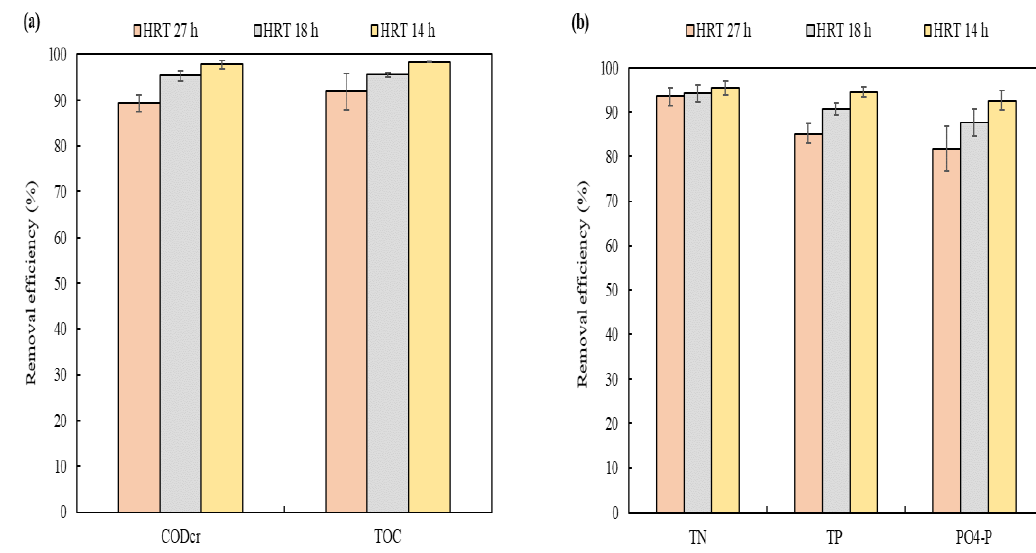
Figure 3. Removal e ffi ciency of ( a ) organic matter and ( b ) nitrogen and phosphorus by HRT ( n = Figure 3. Removal efficiency of ( a ) organic matter and ( b ) nitrogen and phosphorus by HRT (n = 9).